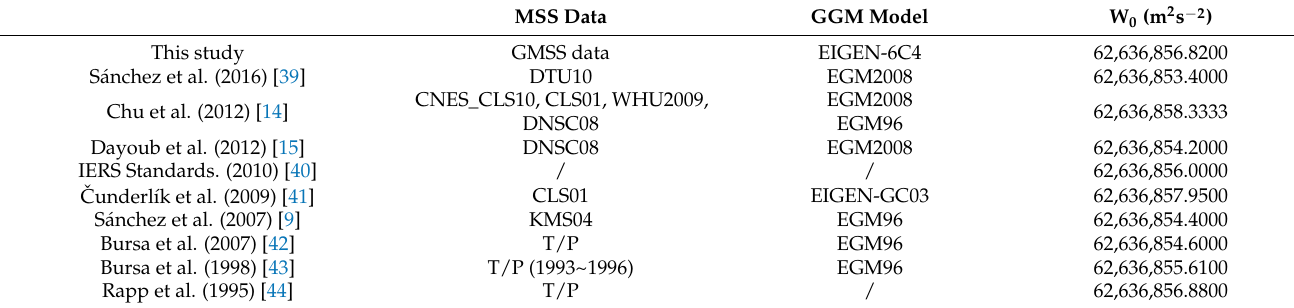
Table 6. W 0 and MDT values calculated using GSSS data and MSS